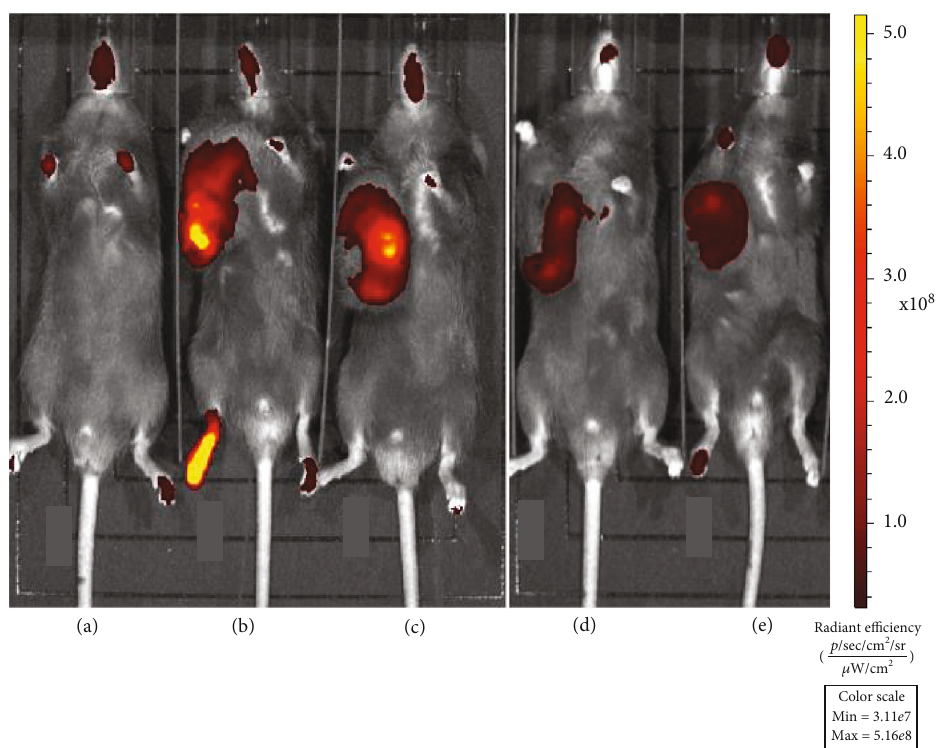
Figure 1: Observation in vivo imaging of the e ff ect of CDDP combined with Akk on the growth of lung cancer in mice. (a) Normal. (b) Model. (c) CDDP. (d) CDDP+Akk. (e)